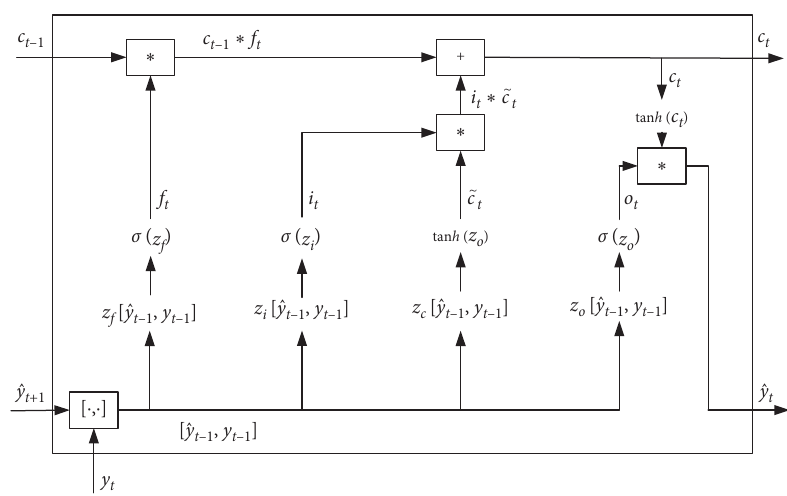
Figure 2: Topology of LSTM